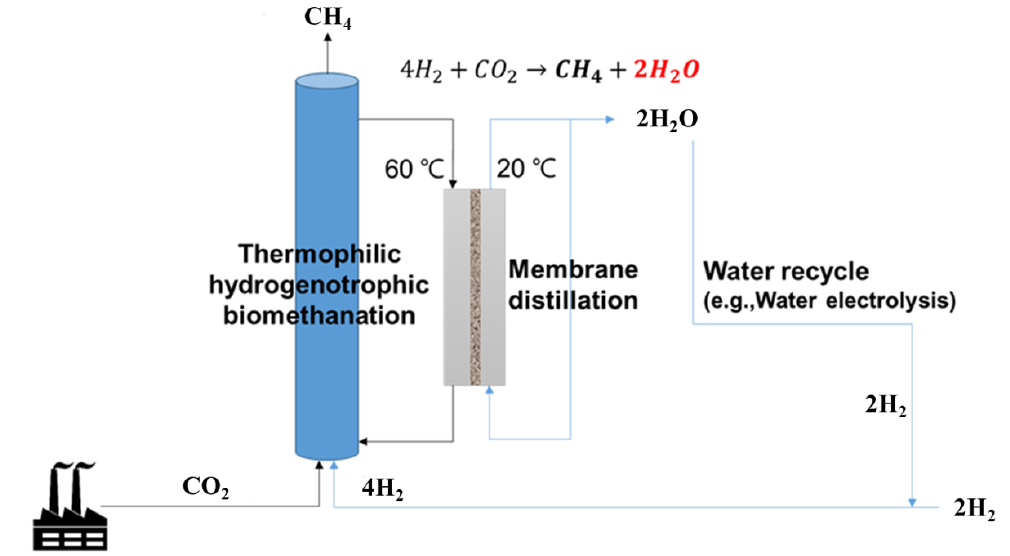
Figure 6. The biomethanation–membrane distillation combination process.